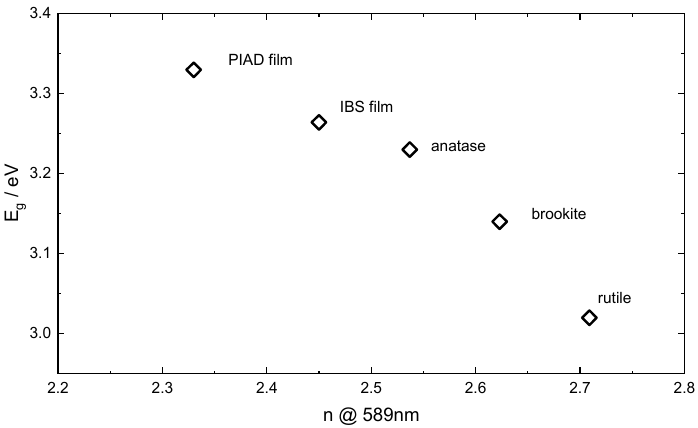
Figure 2. Correlation between optical gap and refractive index for the TiO 2 modifications from Table 1. As previously mentioned, reported values for the nonlinear optical constants of TiO 2 are rare. Table 2 presents some published values of nonlinear refractive indices and absorption coe ffi